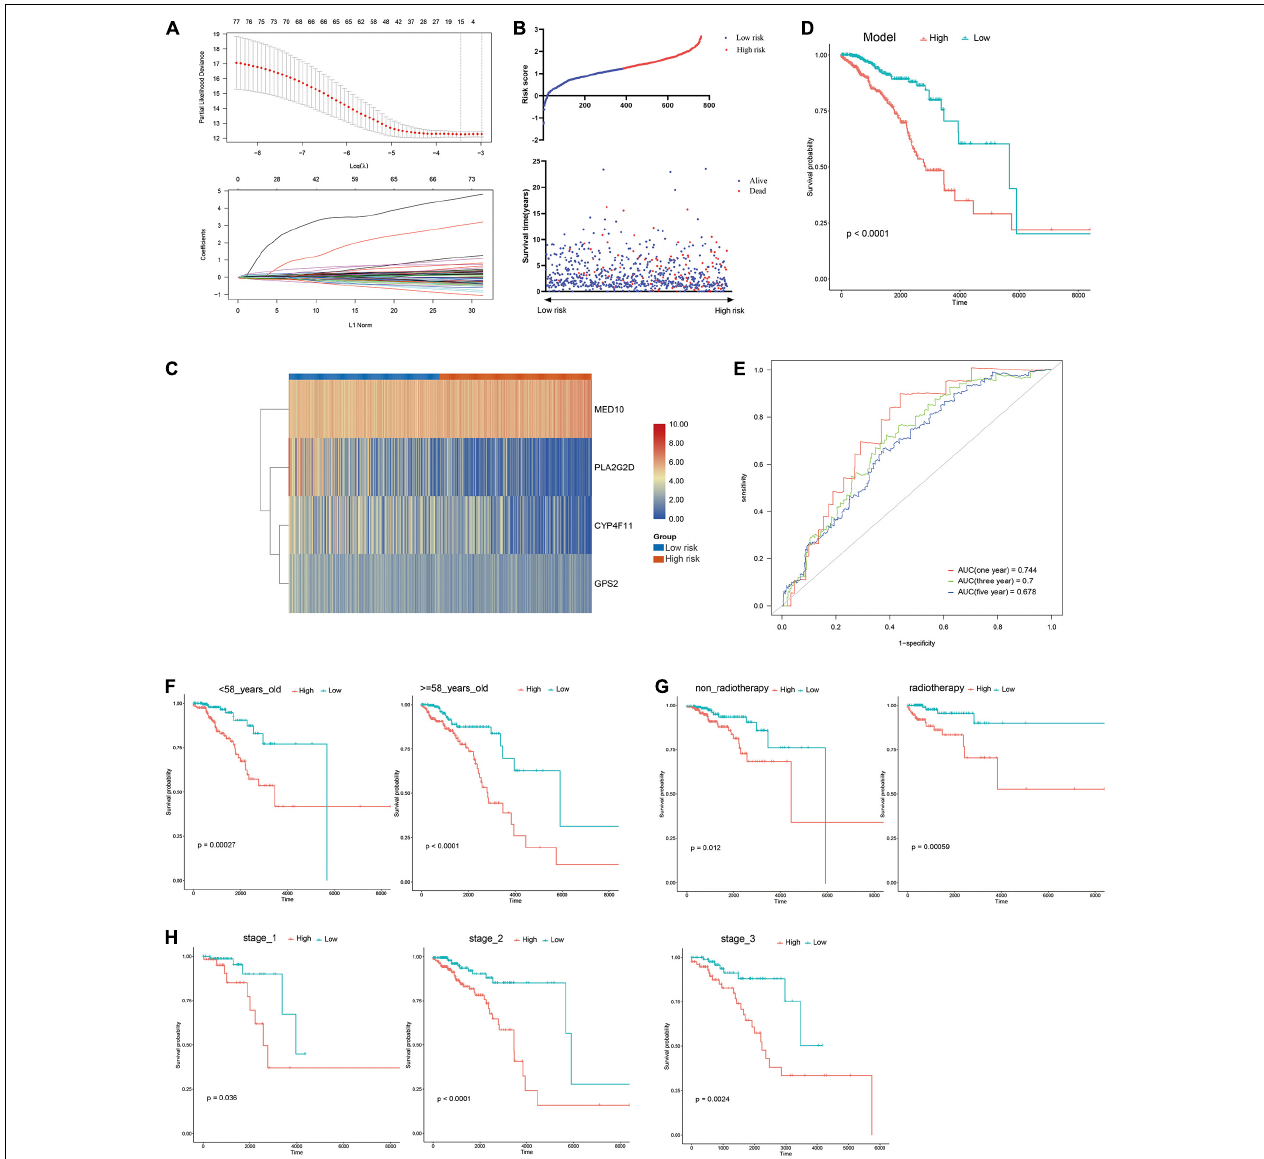
FIGURE 4 | Construction of risk model. (A) LASSO analysis revealing the minimal lambda, (B) survival status and risk score, (C) heatmap visualizing the expression pattern of the four candidate LMAGs, (D) survival curve illustrating the overall survival of the BRCA patients, (E) time-dependent ROC curve, (F–H) subgroup analyses suggesting the independence of the risk model regarding age, radiotherapy, and tumor